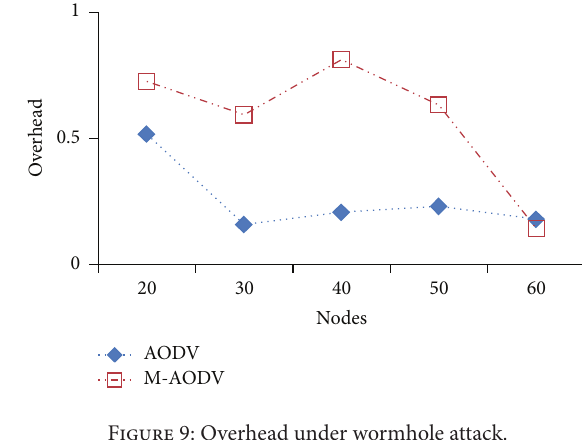
Figure 9: Overhead under wormhole attack.